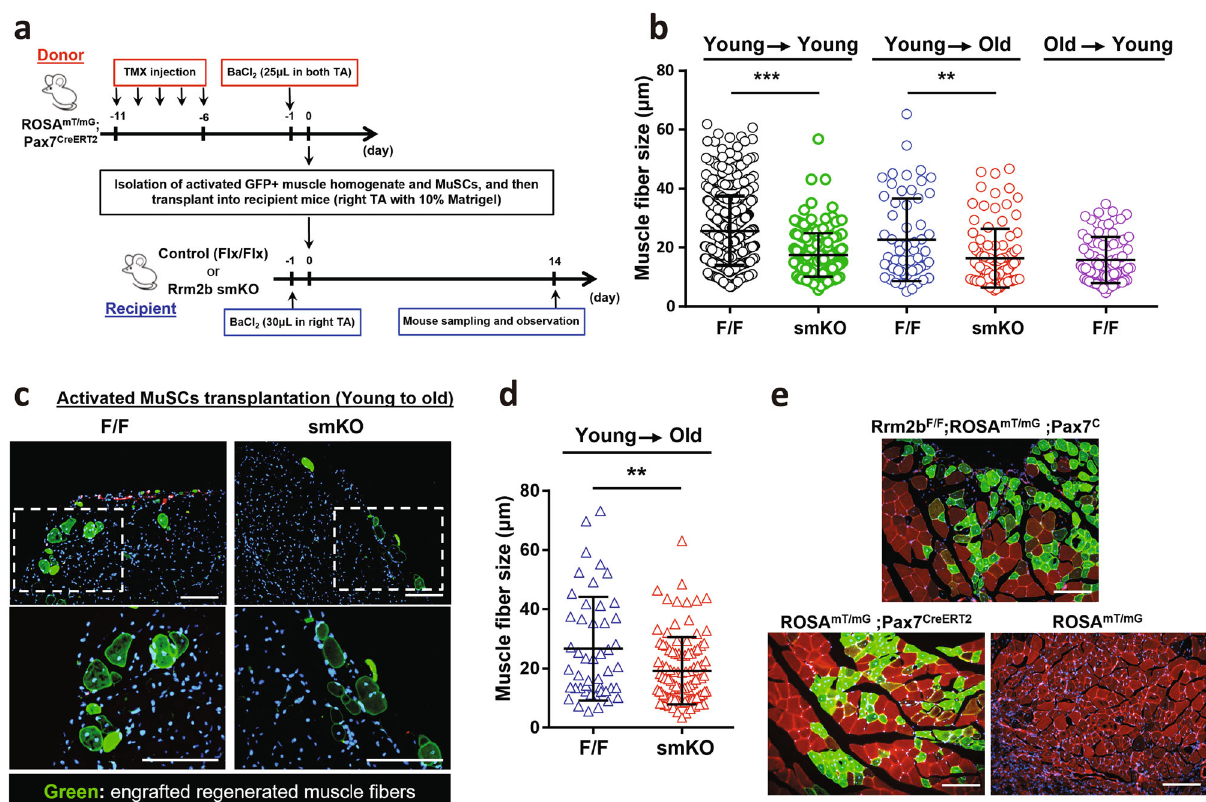
Fig. 4 Myo fi ber-speci fi c Rrm2b deletion weakens the regenerative capacity. a Donor and recipient mouse preparation timetable for muscle homogenate and MuSCs transplantation. b Quanti fi cation of engrafted myo fi ber size from homogenate transplantation between Rrm2b smKO and F/F mice. Each spot indicates one engrafted myo fi ber (myo fi bers with green fl uorescence). c Representative images of engrafted myo fi bers in old recipient TA muscle. 14 days after MuSCs transplantation, activated MuSCs from young donors engrafted old recipient mice and differentiated into green myo fi bers with central nuclei. Scale bar, 100 μ m. d Quanti fi cation of engrafted myo fi ber size from MuSCs transplantation between Rrm2b smKO and F/F mice. Each spot indicates one engrafted myo fi ber (myo fi bers with green fl uorescence). e Histology of the gastrocnemius muscle from ROSA mT/mG , ROSA mT/mG ;Pax7 CreERT2 , and Rrm2bF/F;ROSA mT/mG ;Pax7 CreERT2 mice at 14 days after damage. The mice were 5 months old, with 3 mice in each group. Scale bar, 100 μ m. The results are presented as the mean ± SD. Statistical analysis of differences between the groups was performed by two-tailed, unpaired t-tests, and the P -values were calculated. Asterisks denote statistically signi fi cant changes from the control and are de fi ned as ** P < 0.01; *** P <